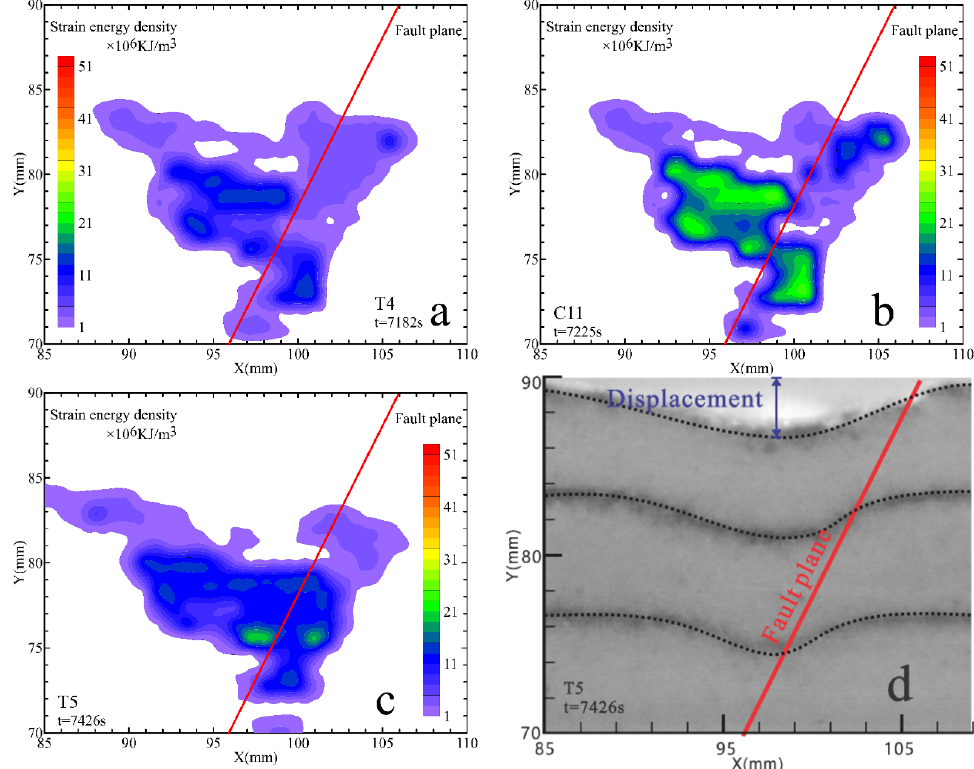
Figure 16. Strain energy density distribution at ( a ) T4, t = 7182 s; ( b ) C11, t = 7225 s; ( c ) T5, t = 7426 s; and, ( d ) the normal fault from the simulation chamber at T5, t = 7426 s. The inception stage of the antithetic goes into the start of the elementary stage for the antithetic fault.